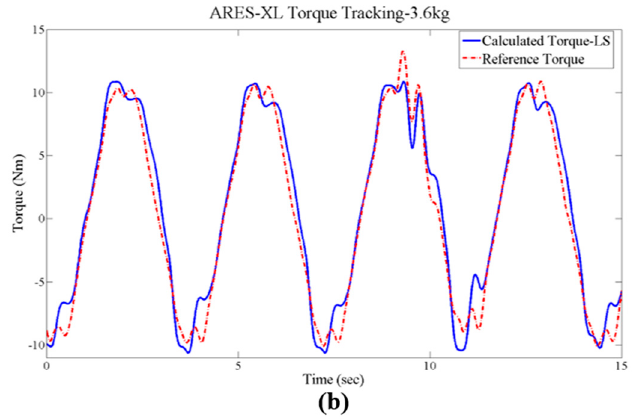
Figure 7. Torque tracking in the ARES-XL at two levels of stiffness and a 3.6 kg load: ( a ) low-stiffness configuration; and ( b ) mid-stiffness configuration.